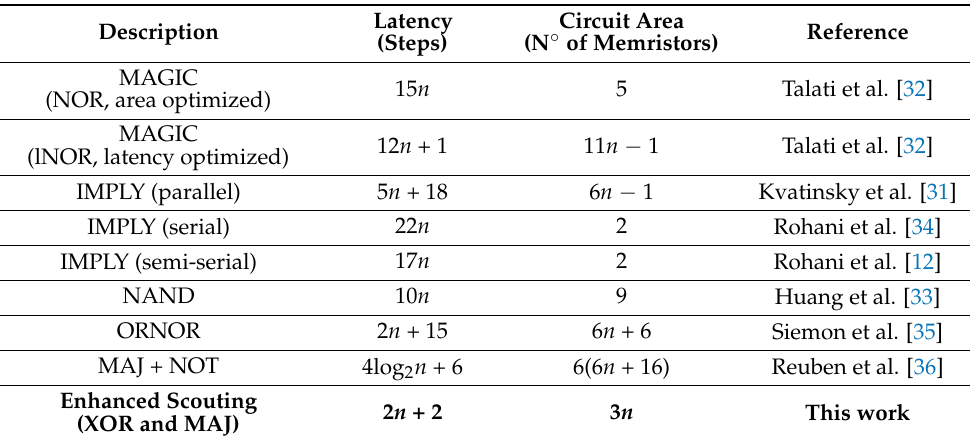
Table 6. Resources required for n -bit binary addition using different in-memory logic approaches.